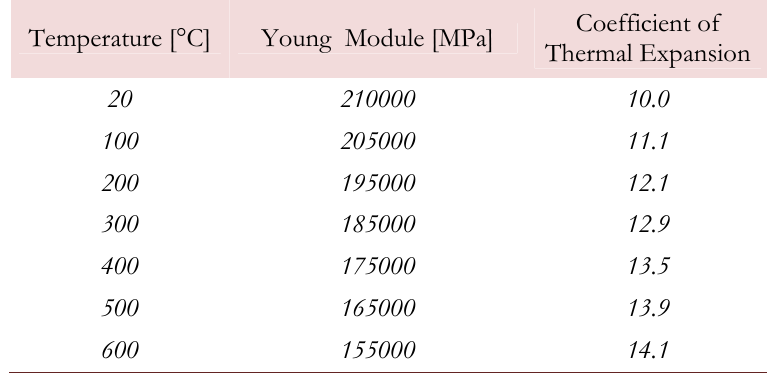
Table 4: Characteristics of the material used for the simulation during the temperature variation.